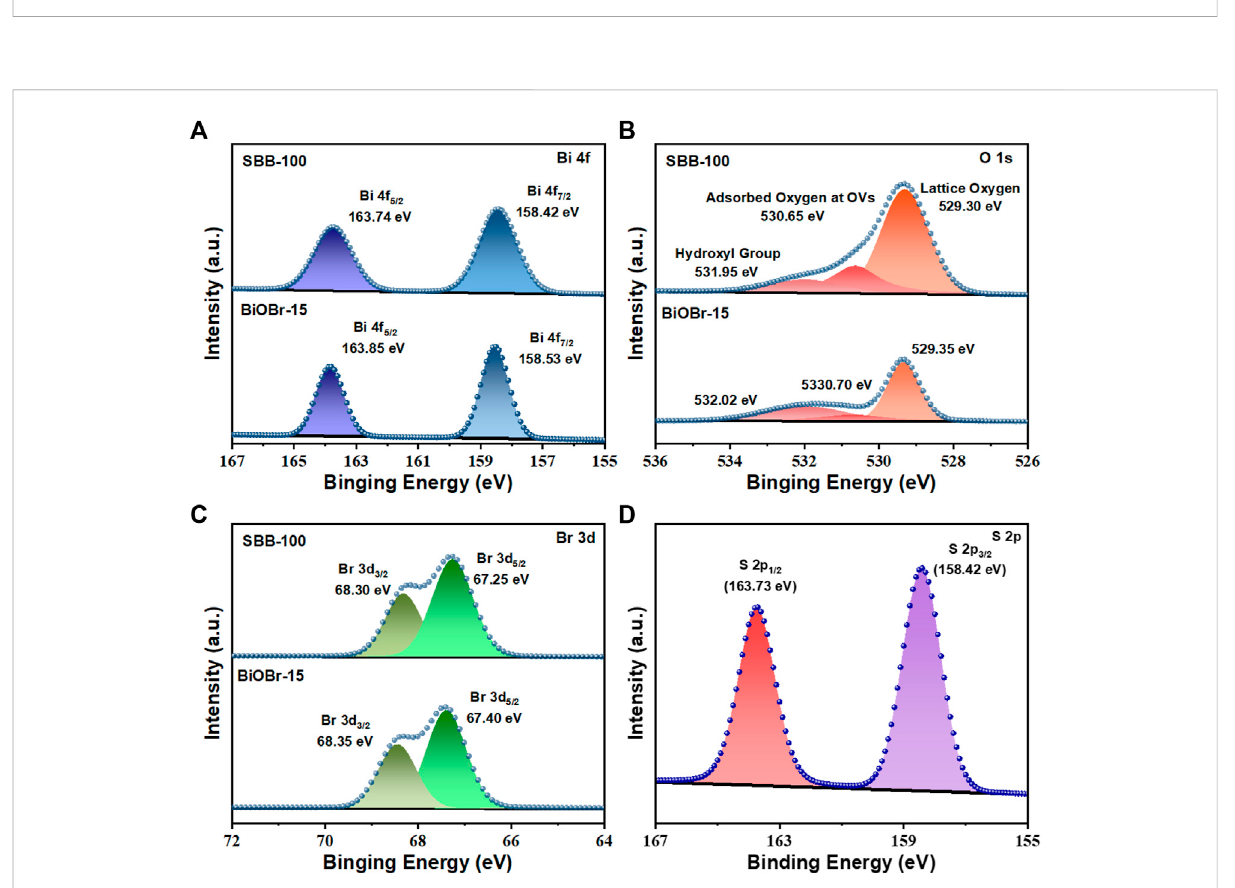
FIGURE 1 XRD pattern of BiOBr@HCs (A) and S-BiOBr (B)